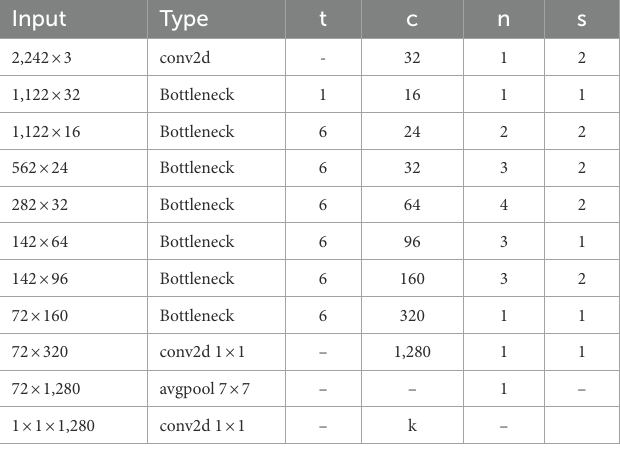
TABLE 3 Mobile net model hyper